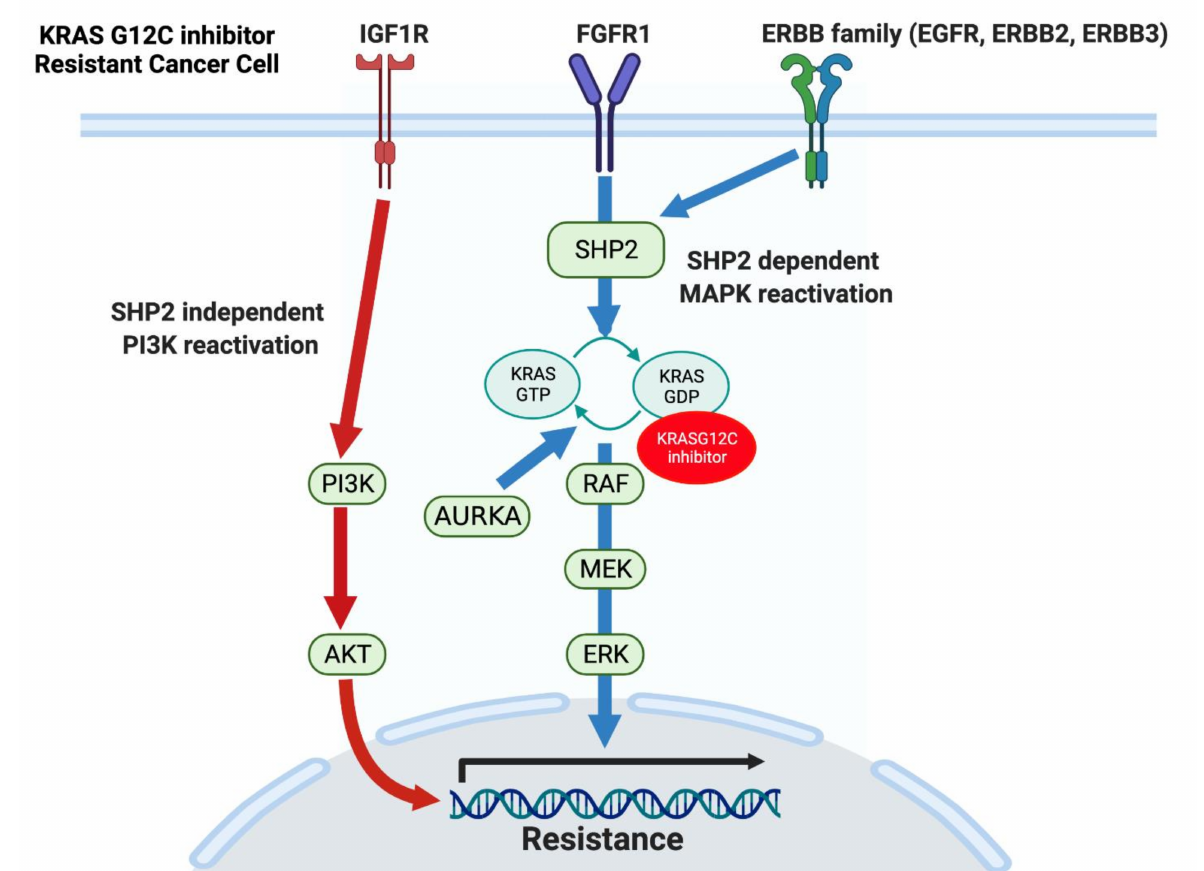
Figure 2. Mechanisms of resistance to KRAS G12C inhibitors. Inhibition of MAPK signaling by G12C inhibitors induces feedback reactivation of MAPK via multiple receptor tyrosine kinases, including FGFR1 and ERBB family members. While FGFR1 and ERBB3 reactivate the MAPK signaling pathway through adaptor protein SHP2, IGF1R leads to SHP2- independent activation of the PI3K signaling pathway. Additionally, activation of EGFR and Aurora kinase following KRAS G12C inhibitor treatment leads to protein synthesis and activation of KRAS G12C. The newly synthesized and activated G12C proteins are resistant to KRAS G12C inhibition due to their GTP-bound form. Furthermore, mutations in MAPK proteins can induce constitutive MAPK activation in the presence of KRAS G12C inhibitors. Activation of PI3K and MAPK leads to transcription of genes related to cell proliferation and survival (black arrow). Abbreviations: EGFR, Epidermal growth factor receptor; ERBB, Erb-B2 Receptor Tyrosine Kinase; FGFR1, Fibroblast growth factor receptor 1; IGF1R, Insulin-like growth factor 1 receptor; MAPK, Mitogen-activated protein kinase; SHP2, Src homology region 2 domain-containing phosphatase